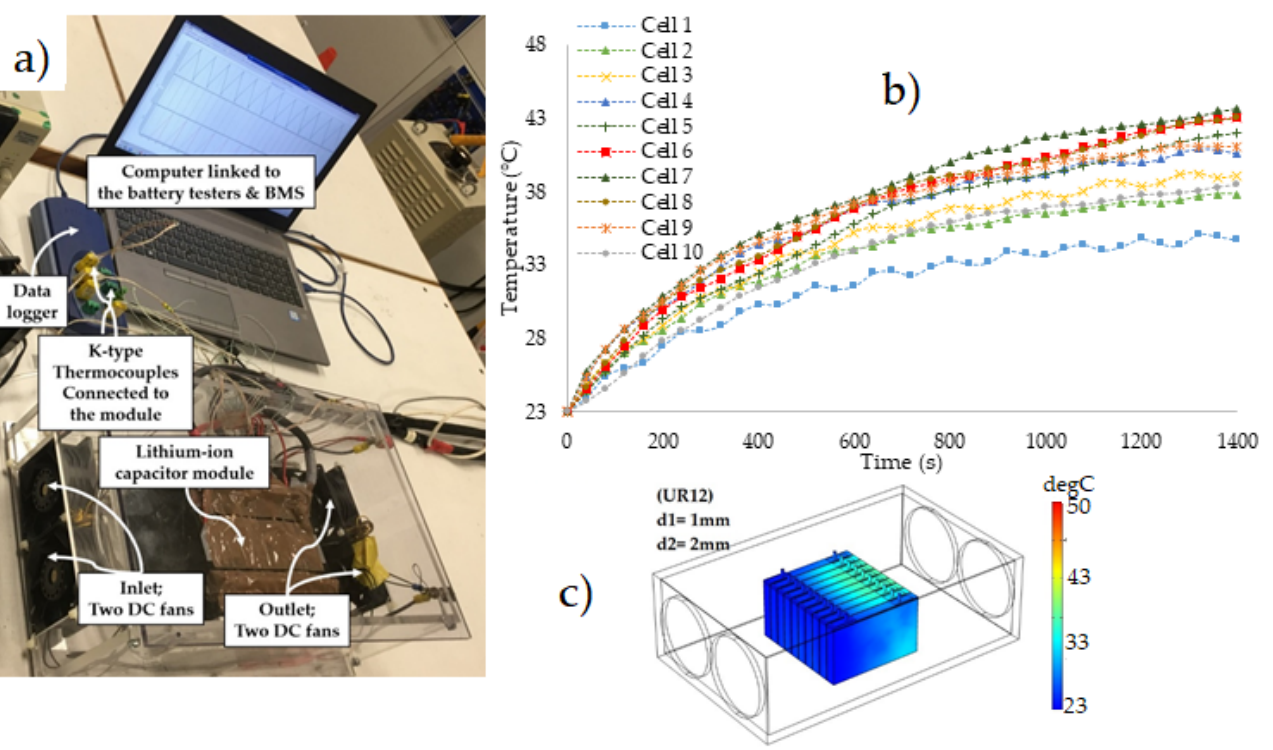
Figure 4. ( a ) The experimental test bench of the air-cooled system for the LiC module; ( b ) the temperature evolution of 10 thermocouples on different positions of the module; ( c ) the temperature distribution of the module in the most optimal case study [18].